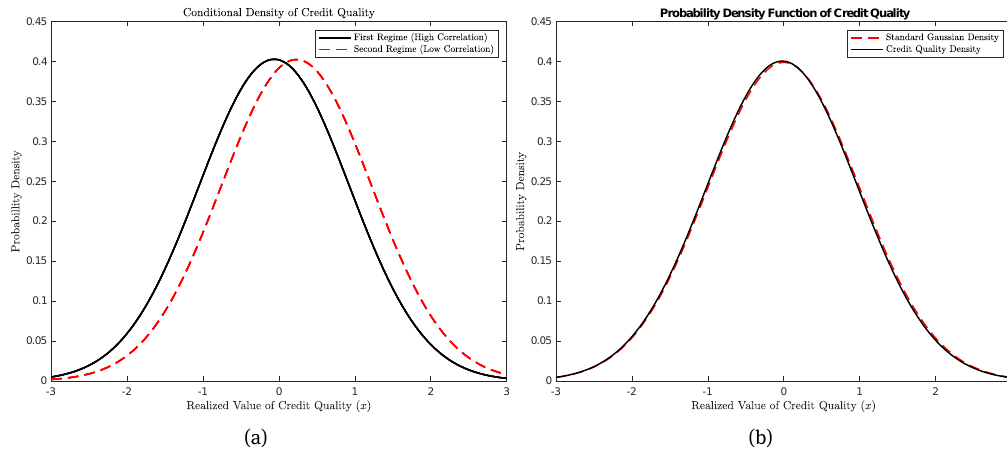
Figure 4.2: Panel (a) illustrates the conditional density of an individual credit quality in each regime, in our numerical example. The expression for the conditional density in regime k is given by (4.17) . In the first regime (solid line) the density resembles a skew-normal density with negative skew, in the second regime (dashed line) the density resembles a skew-normal density with positive skew. Panel (b) illustrates the unconditional density of an individual credit quality in our numerical example and, for a point of reference, compares it to a standard normal density. Recall that the unconditional density here is of the form ϕ ( x )· r ( x ) , where r ( x ) = (cid:80) K r k ( x ) and r k ( x ) is given by (4.18) . Note that r ( x ) is a non-negative function such that r ( x ) → 1 as x → ±∞ k =1